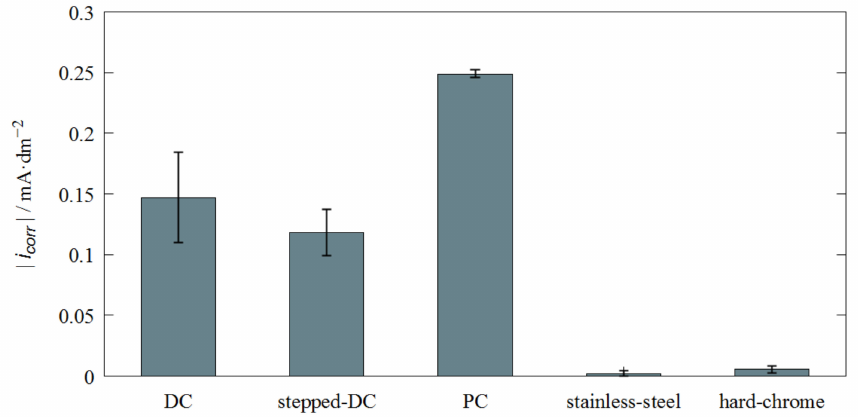
Figure 9. Corrosion current density of electrodeposited Fe-Cr-Ni and hard-chrome